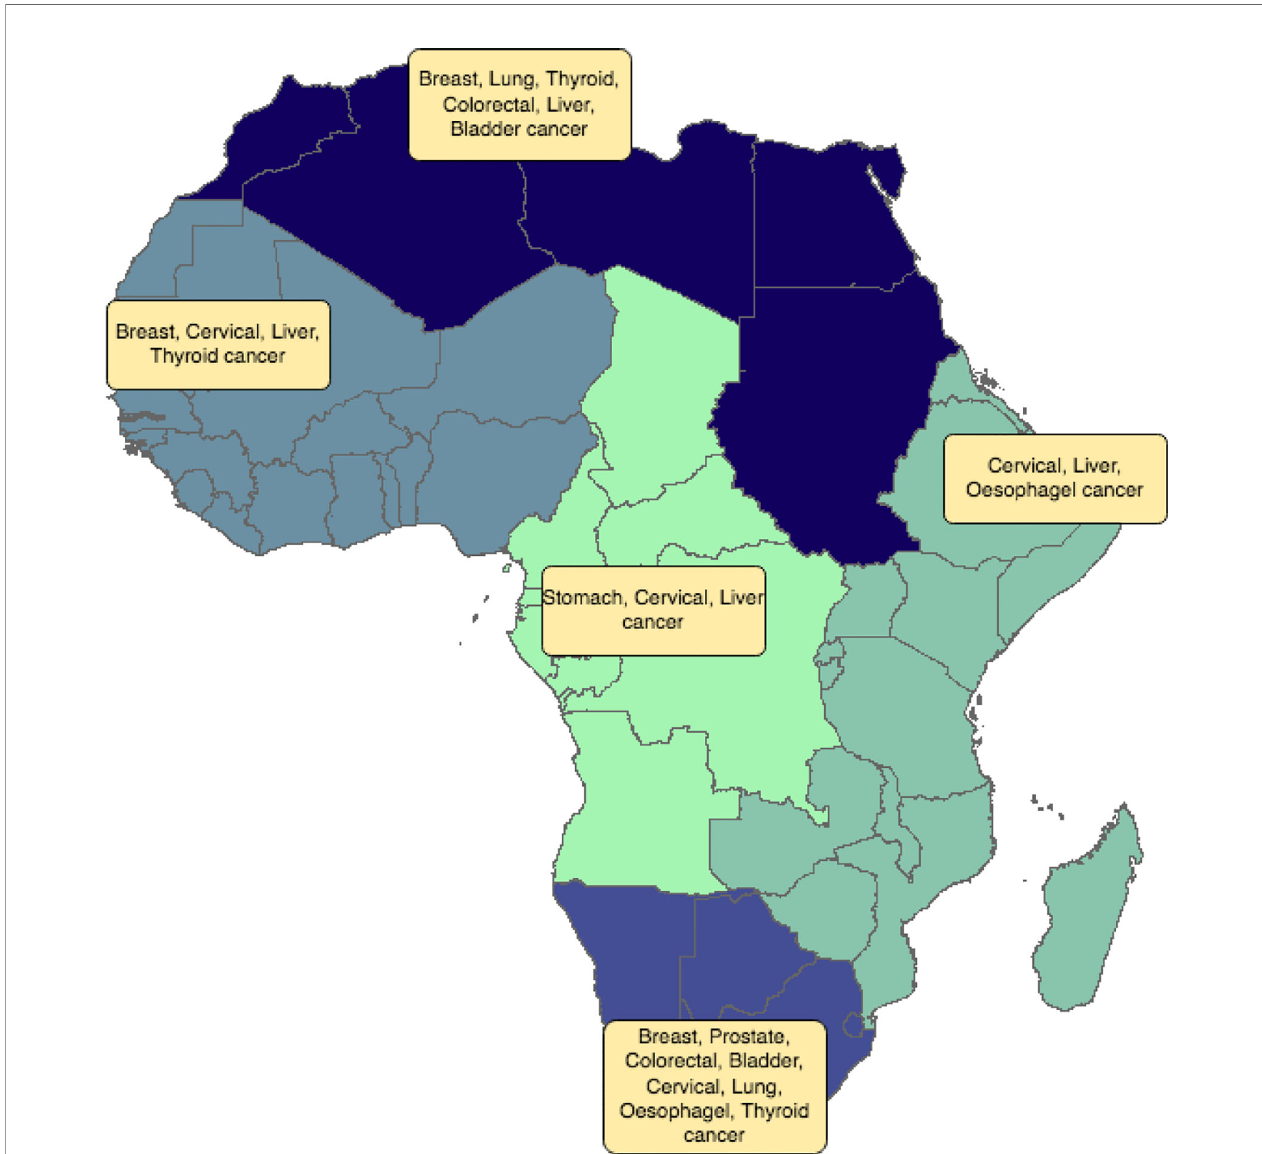
FIGURE 13 | Distribution of the most frequent cancer types by African region. Different colors refer to the different African regions (North, East, West, Central and Southern